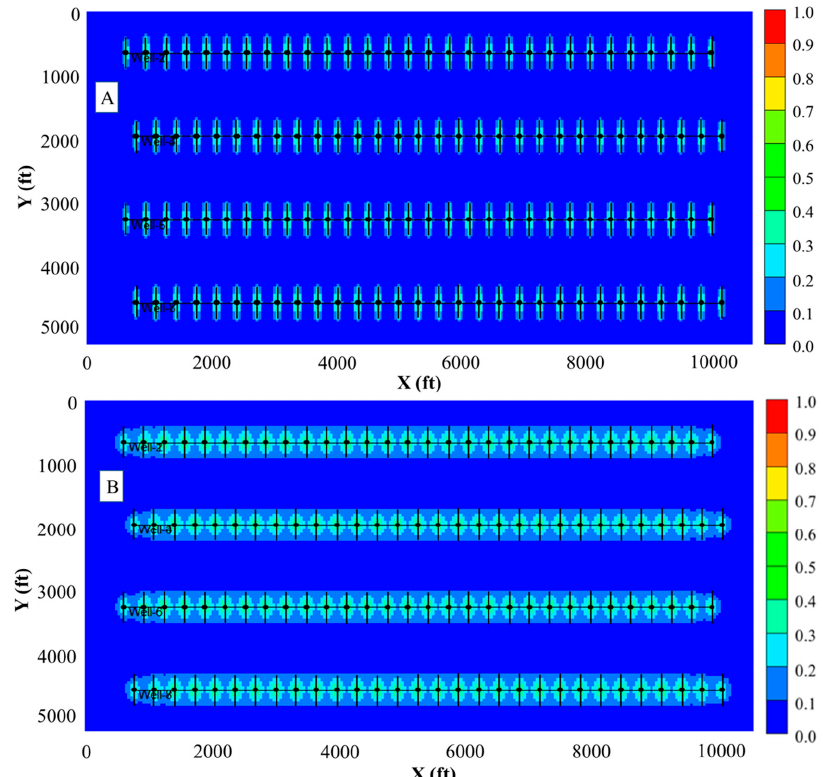
Figure 11. Comparisons of distribution of CO 2 mole fraction with and without molecular diffusion. ( a )Without molecular diffusion (Case B); ( b )With molecular diffusion (Case C).